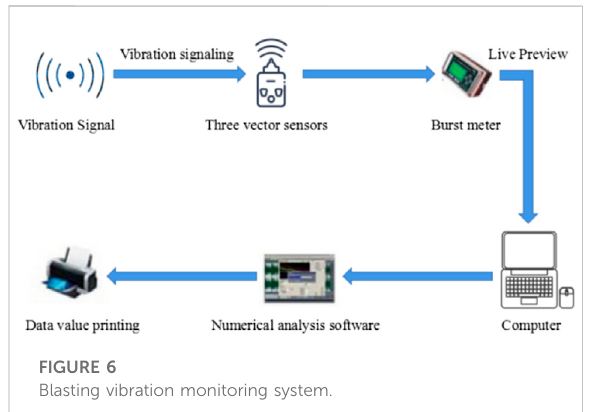
FIGURE 6 Blasting vibration monitoring system.